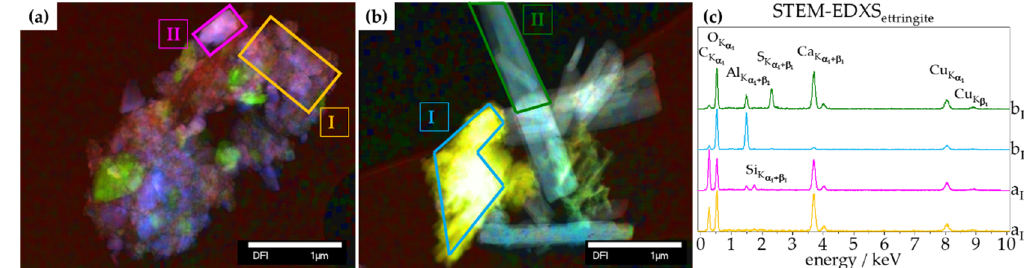
Figure 2. STEM micrographs of pristine ettringite ( a , b ) sites of EDXS and ( c ) corresponding STEM-EDXS spectra of different sites.